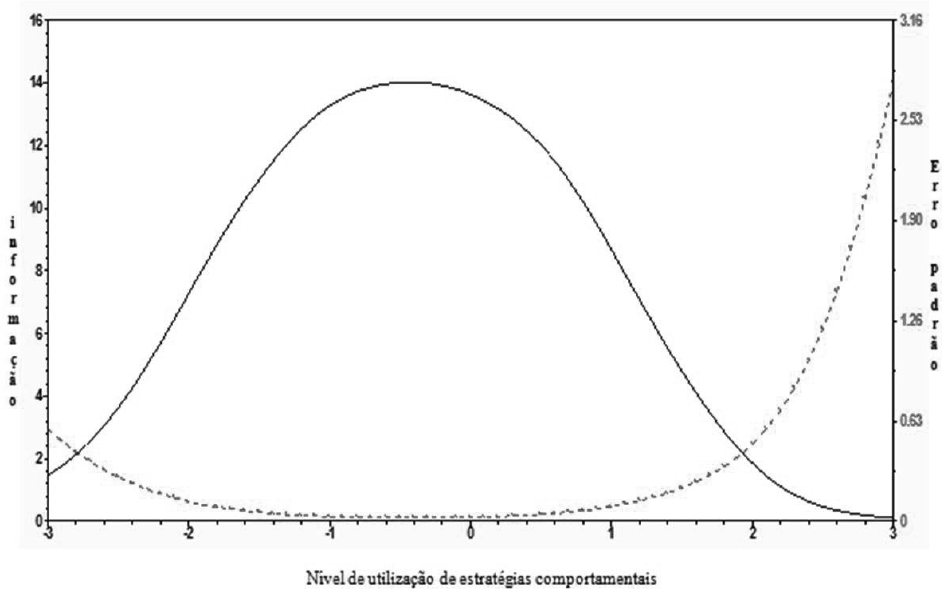
Figura 1 . Curvas de informação e de erro da medida (MRG) da Escala de Estratégias Comportamentais de Aplicação do Aprendido no